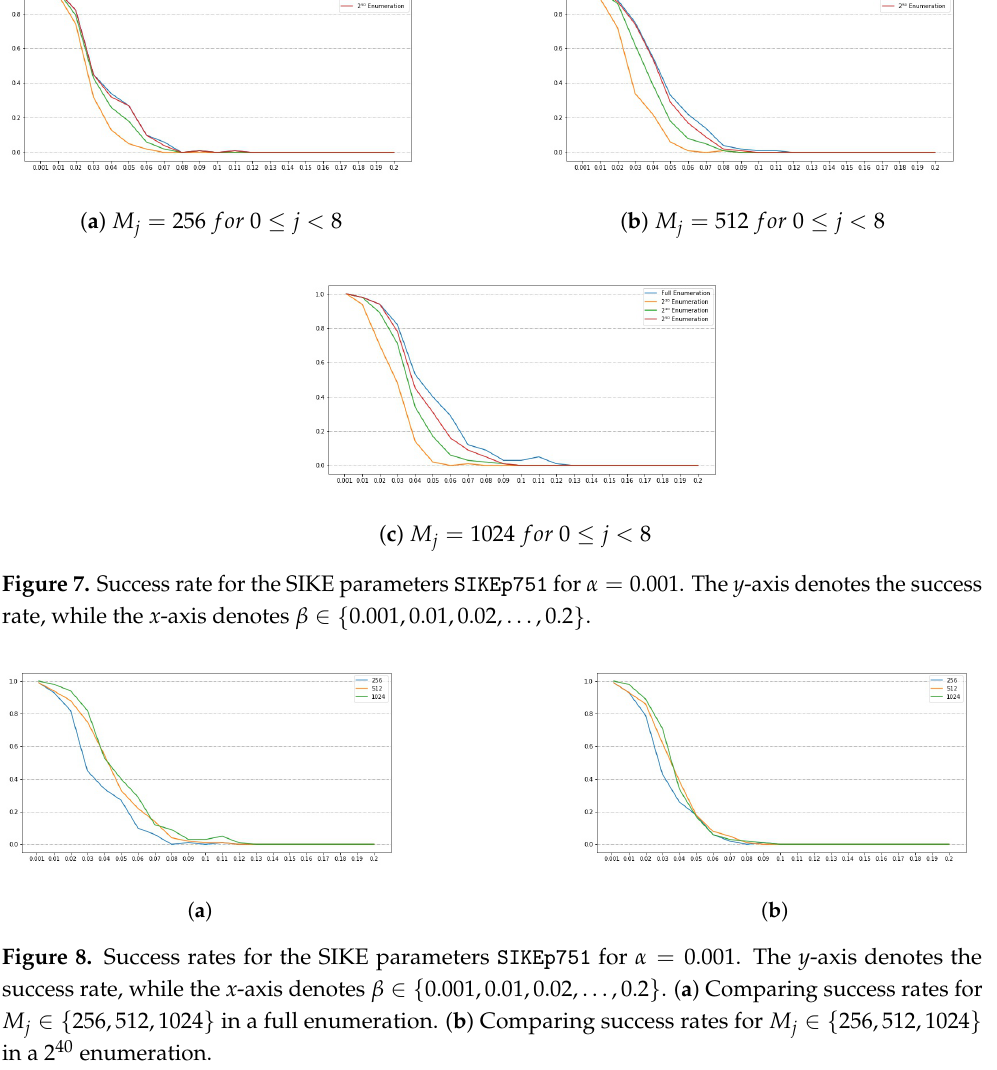
Figure 8. Success rates for the SIKE parameters SIKEp751 for α = 0.001. The y -axis denotes the success rate, while the x -axis denotes β 0.001,0.01,0.02, . . . ,0.2 . ( a ) Comparing success rates for ∈ { } M j 256,512,1024 in a full enumeration. ( b ) Comparing success rates for M j 256,512,1024 in a ∈ { } ∈ { } 2 40 enumeration.